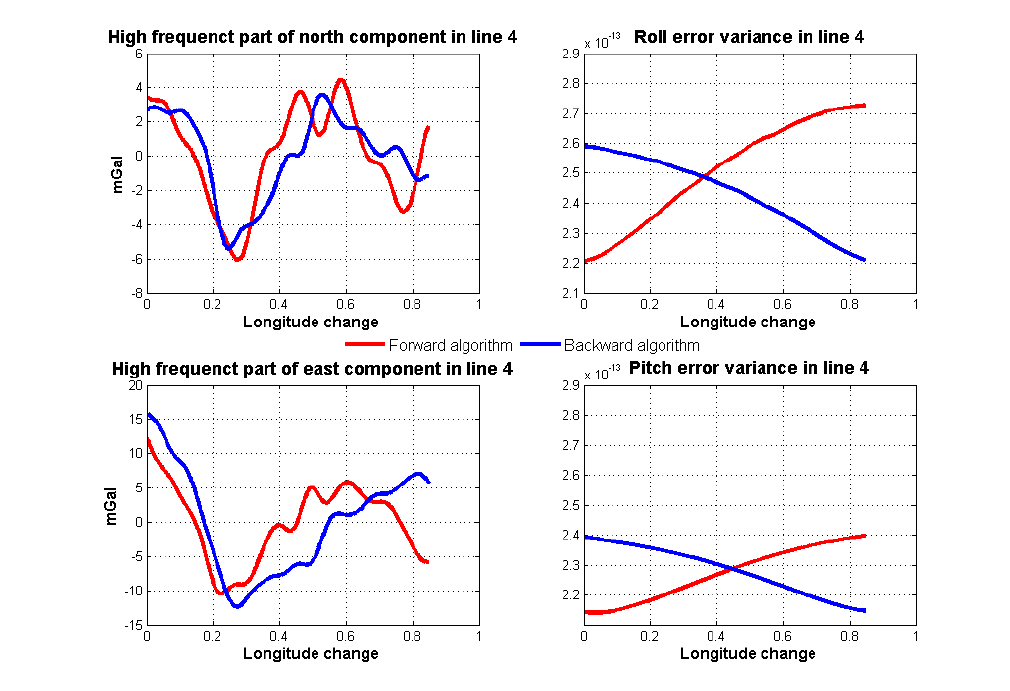
Figure 18. Estimated variances of attitude error and high frequency part of gravity disturbance horizontal components in line 4.